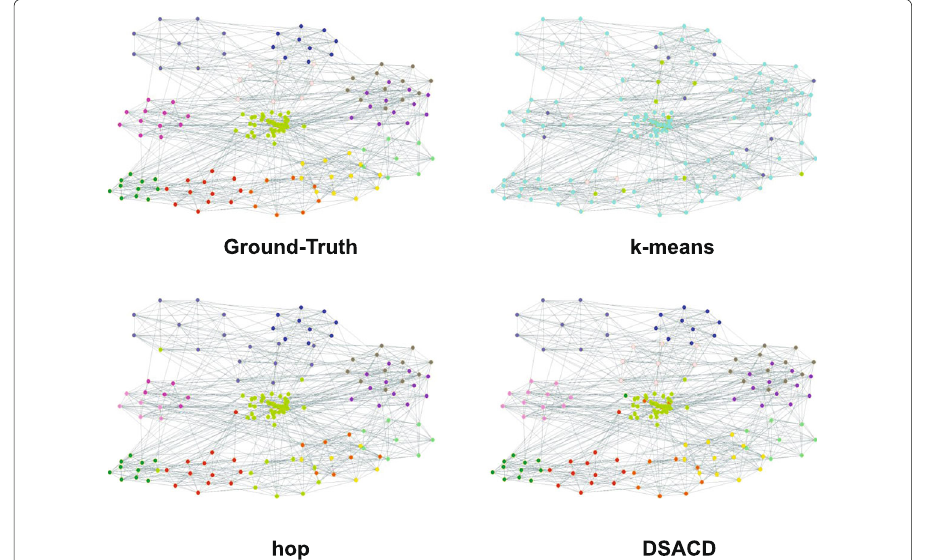
Fig. 10 Comparison of the true results of the football dataset and different clustering